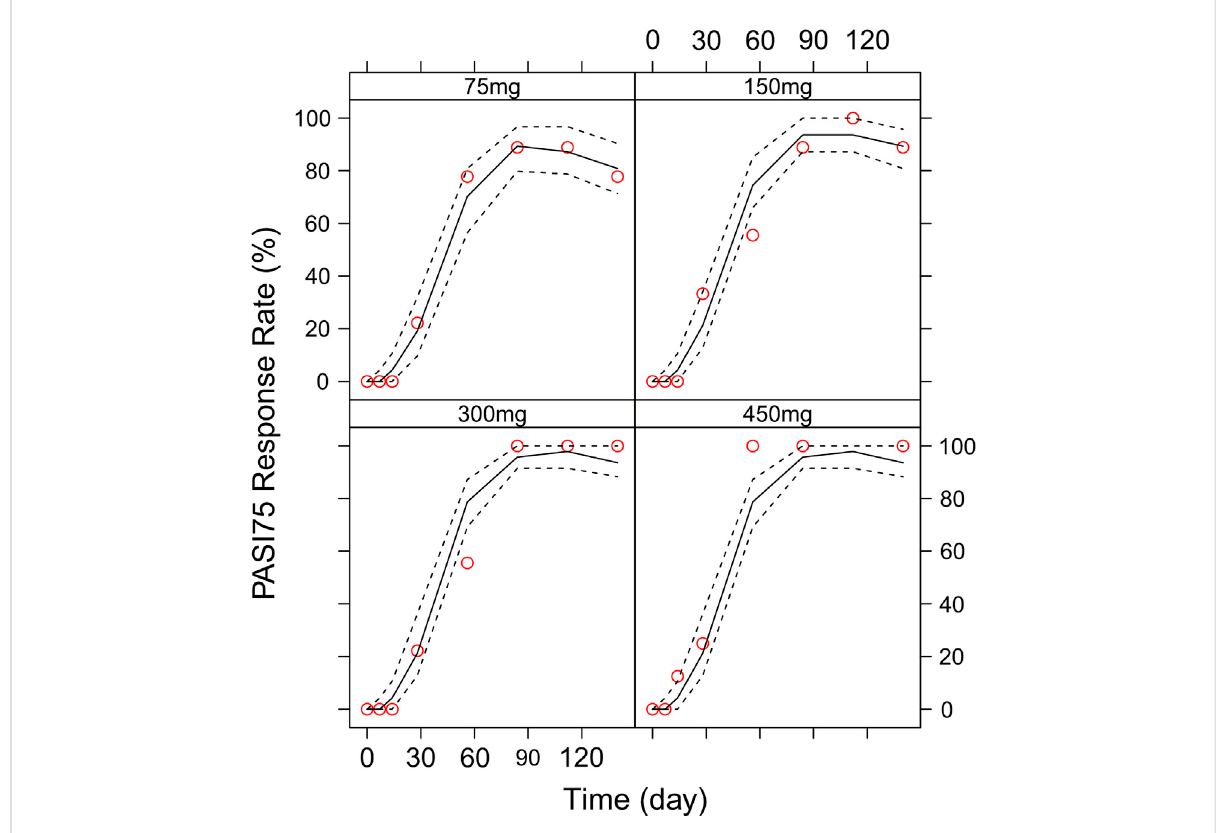
FIGURE 8 Comparison of the observed time pro fi les of PASI75 and PASI90 response rates versus model-predicted time pro fi les strati fi ed by dose. Observed and predicted PASI75 response rates strati fi ed by